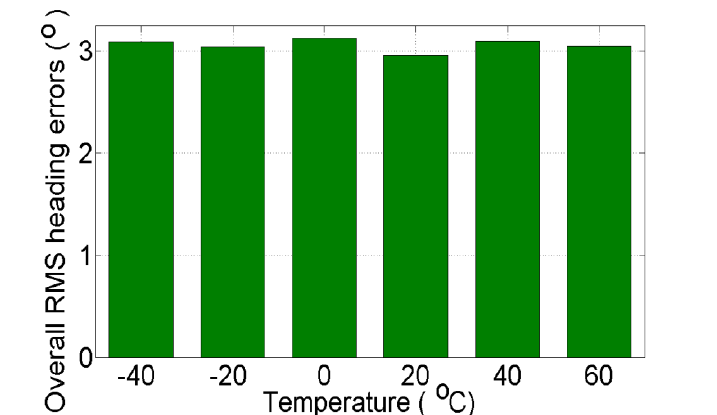
Figure 15. Overall RMS errors of the heading solution using kinematic test data collected at +17 °C and the AR-based GM model developed at different temperature